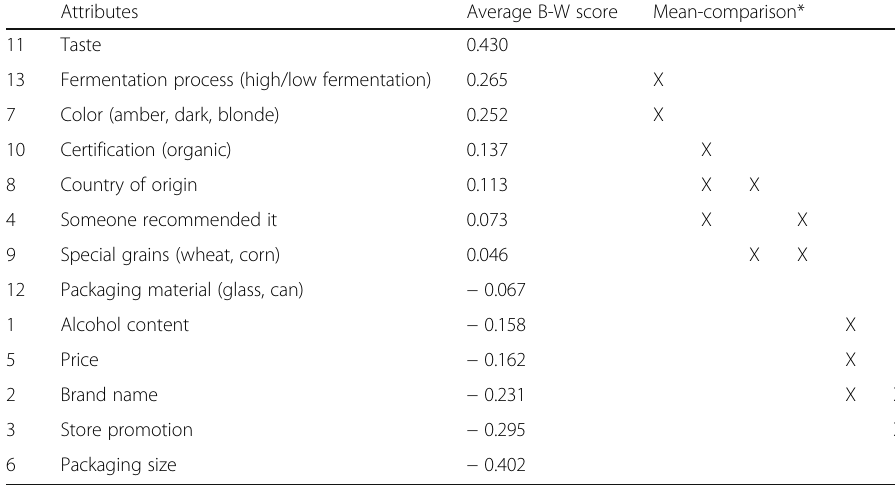
Table 6 Mean comparison of craft beer attributes for respondents Attributes Average B-W score Mean-comparison*